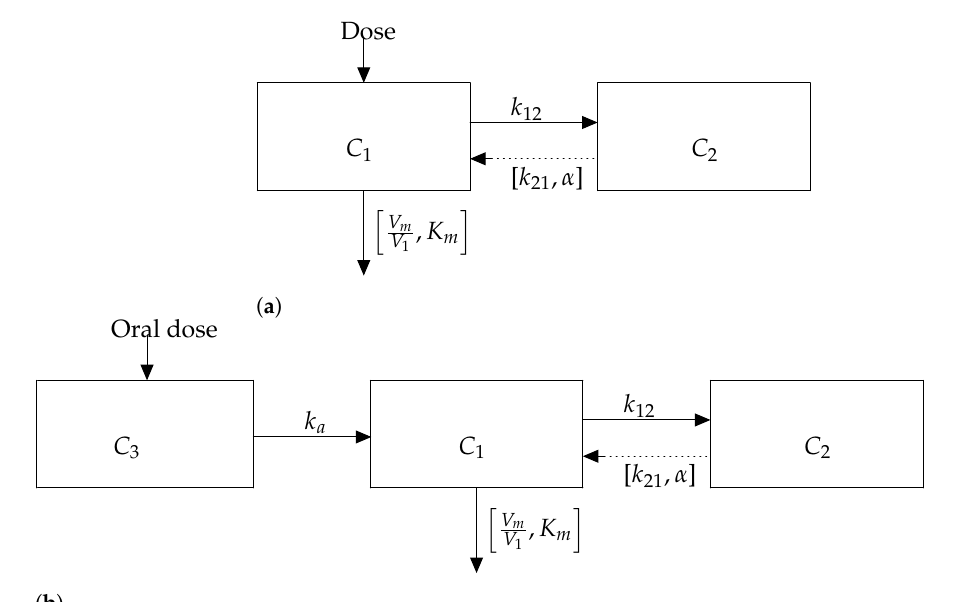
Figure 1. Fractional compartment PK models. First-order absorption and elimination. The flux from the peripheral to the central compartment follows the slower distribution fractional kinetics of the drug, while flux from the central to peripheral compartment follows fast distribution kinetics. The dif- ference in the distribution and redistribution rate is based on the central compartment consisting of the plasma and tissues that distribute the drug instantaneously. In contrast, the peripheral compart- ment consists of slow distribution. ( a ) Model 1: The dose is administered in the central compartment as an IV bolus. ( b ) Model 2: The dose administered orally through the gastrointestinal